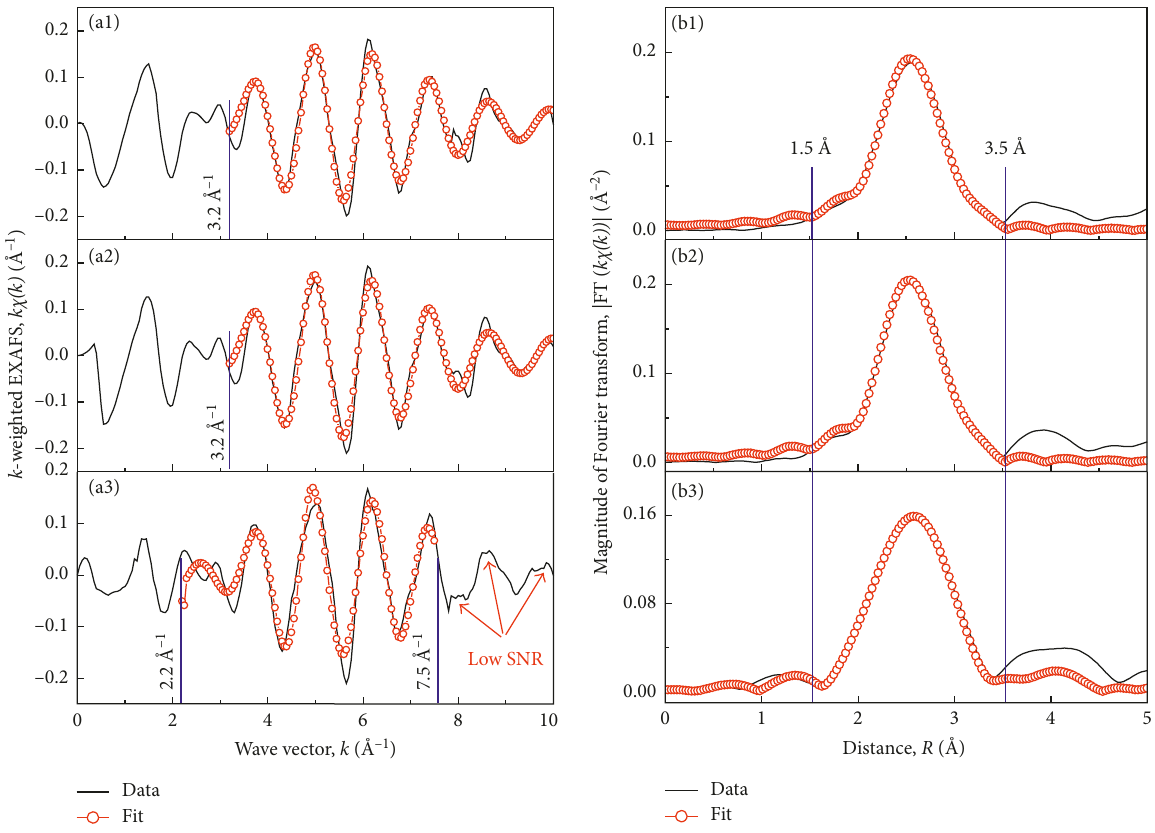
Figure 4: k k functions (a1–a3) and FT- k ( ) (a2, b2) Annealed alloy. (a3, b3) As-spun χ